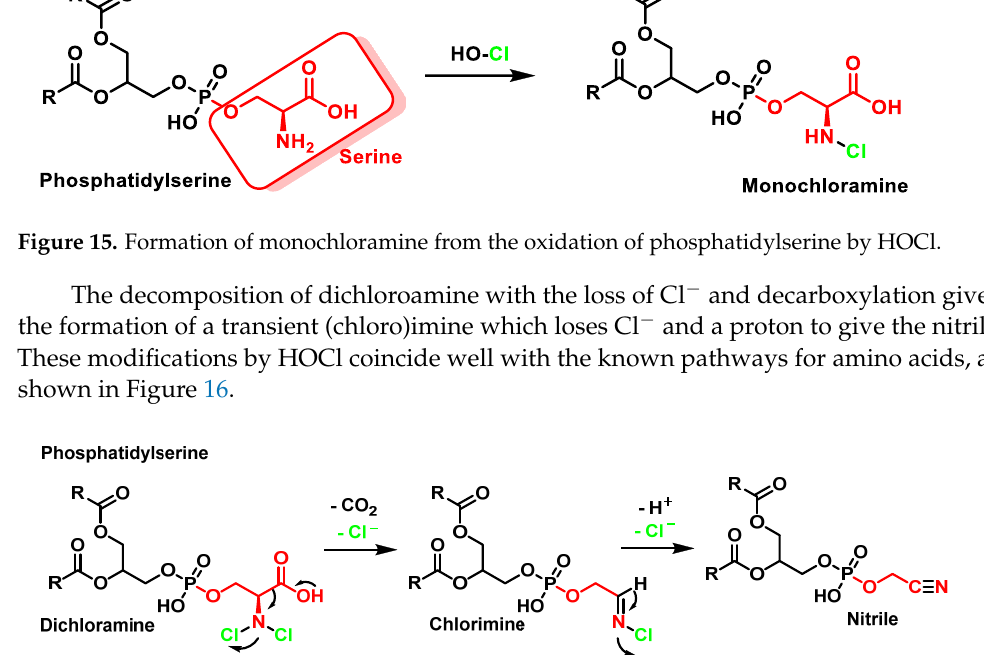
Figure 17. Conversion of the amino group of phosphatidylethanolamine and phosphatidylserine by reaction with HOCl.